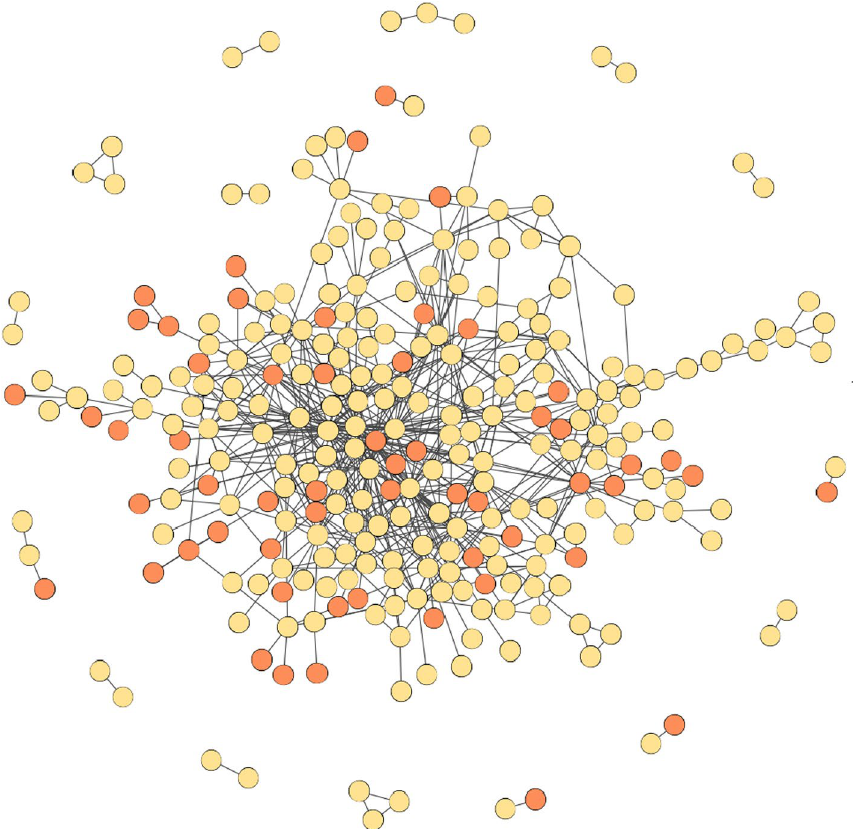
Fig. 1 R&B/hip hop collaboration network 2012–2020. Men are represented by yellow circles and women are orange circles. Edges indicate that the two artists collaborated on a hip hop/R&B song that was featured on